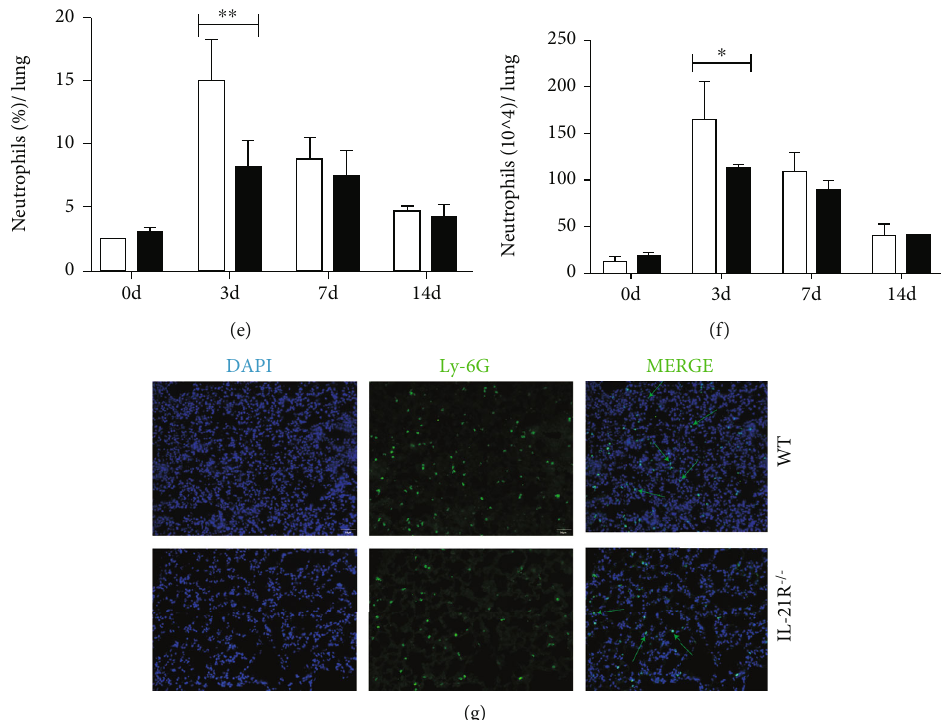
Figure 1: Pulmonary neutrophil in fi ltrations of IL-21R -/- mice in response to Chlamydia muridarum ( C. muridarum ) lung infection. The lung single cells of wild-type (WT) and IL-21 receptor de fi cient (IL-21R -/- ) mice were prepared. (a, b) Wright-Giemsa staining of lung single cells was performed, and the percentages of monocytes, neutrophils, and lymphocytes in lungs of WT and IL-21R -/- mice following C. muridarum infection were analyzed. (c – f) Flow cytometry performed with pulmonary neutrophils represented as CD45